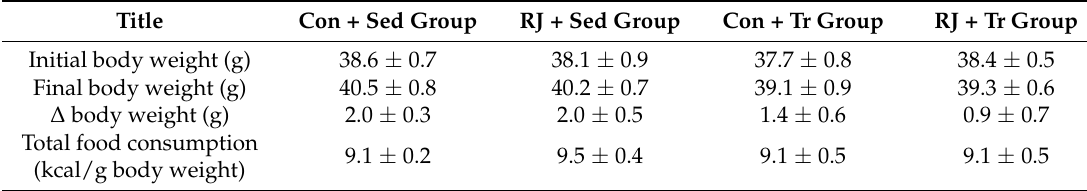
Table 2. Body weight and food consumption of